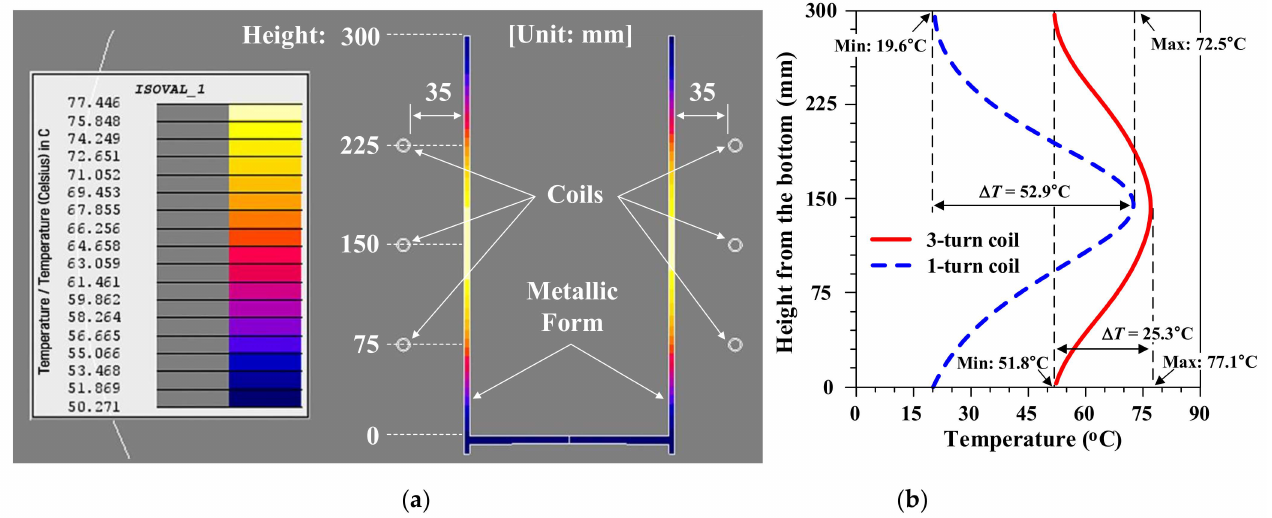
Figure 5. Temperature distribution by a three-turn coil: ( a ) temperature distribution on the surface of formwork; ( b ) temper- ature distribution according to height.